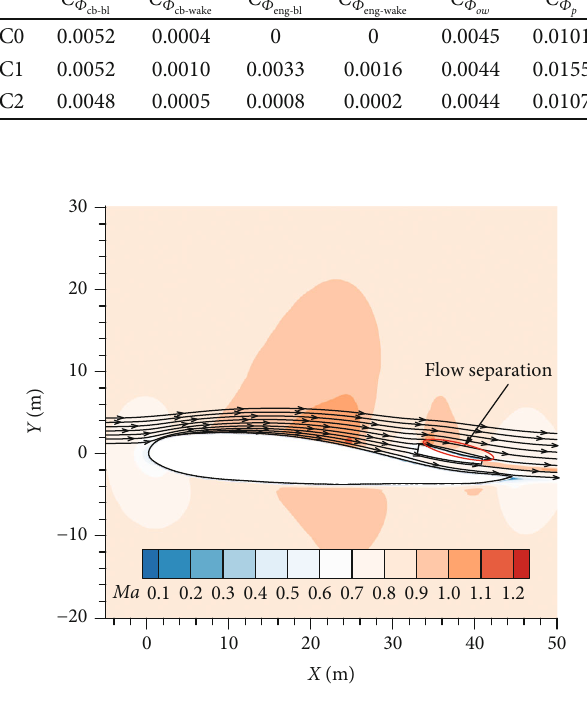
Figure 15: The contours of Mach number and streamline of C